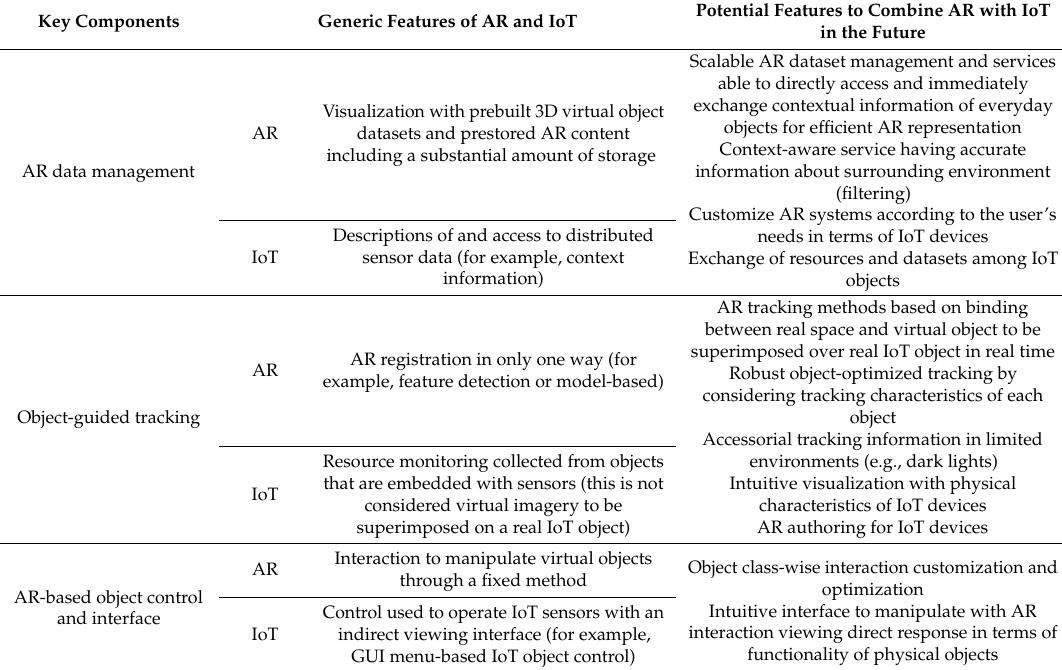
Table 2. Prospective features from combining AR and